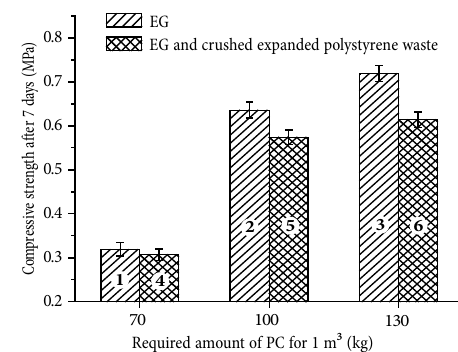
0.20.30.40.50.60.70.8 Required amount of PC for 1 m  (kg) Fig. 4. Influence of the amount of PC on compressive strength after 7 days of LWAC samples of 1÷6 compositions wasteEG EG and crushed expanded polystyrene